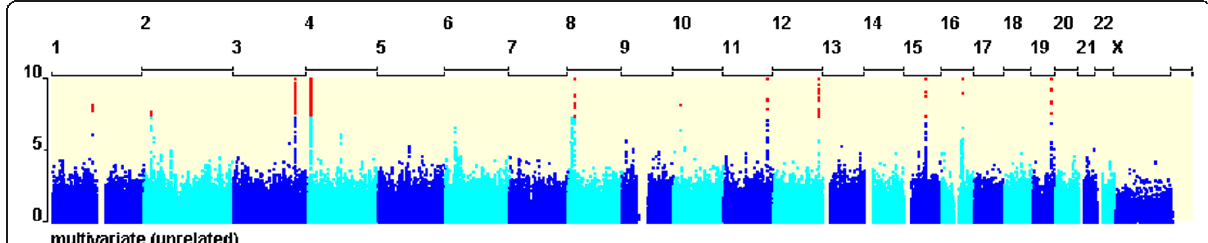
Minor/Major multivariate P- Gene Allele value